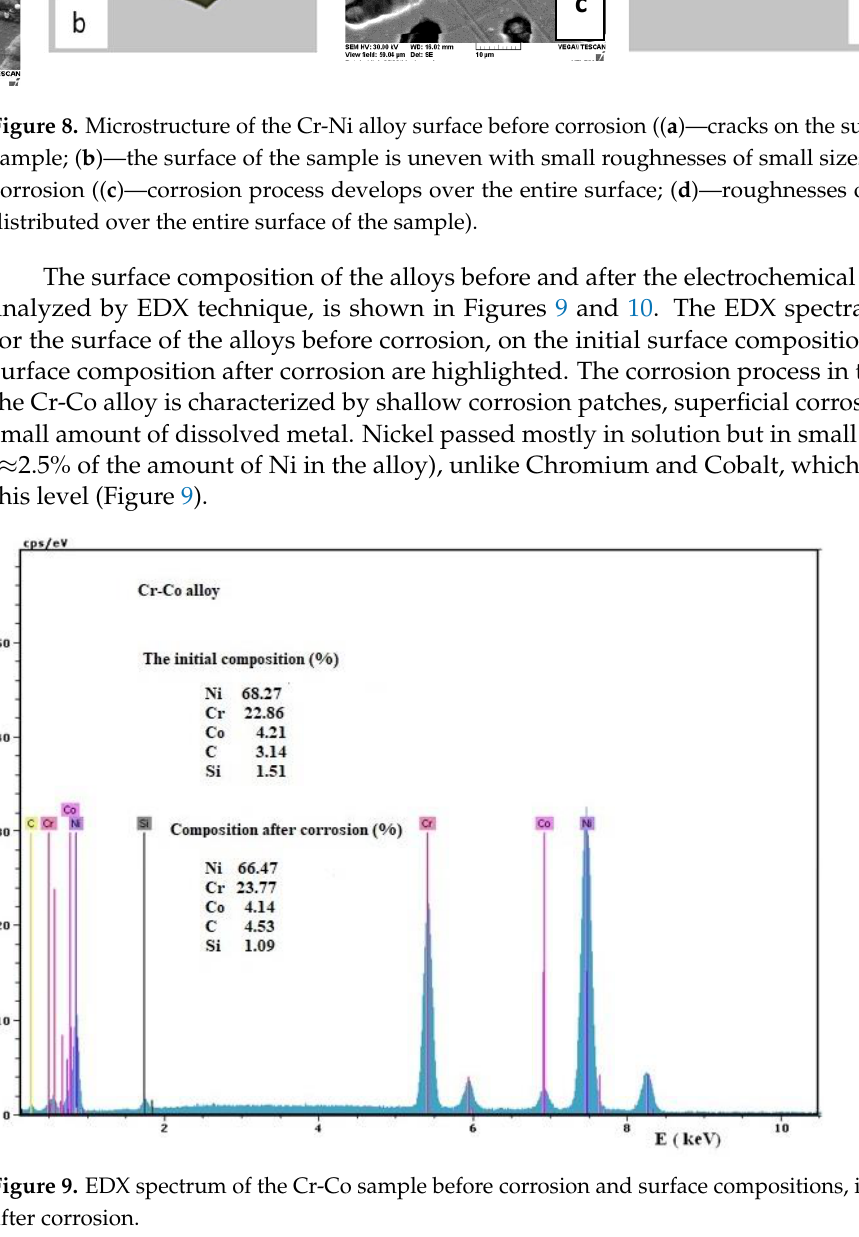
Figure 8. Microstructure of the Cr-Ni alloy surface before corrosion (( a ) — cracks on the surface of the sample; ( b ) — the surface of the sample is uneven with small roughnesses of small sizes) and after corrosion (( c ) — corrosion process develops over the entire surface; ( d ) — roughnesses of varia- bles distributed over the entire surface of the sample).